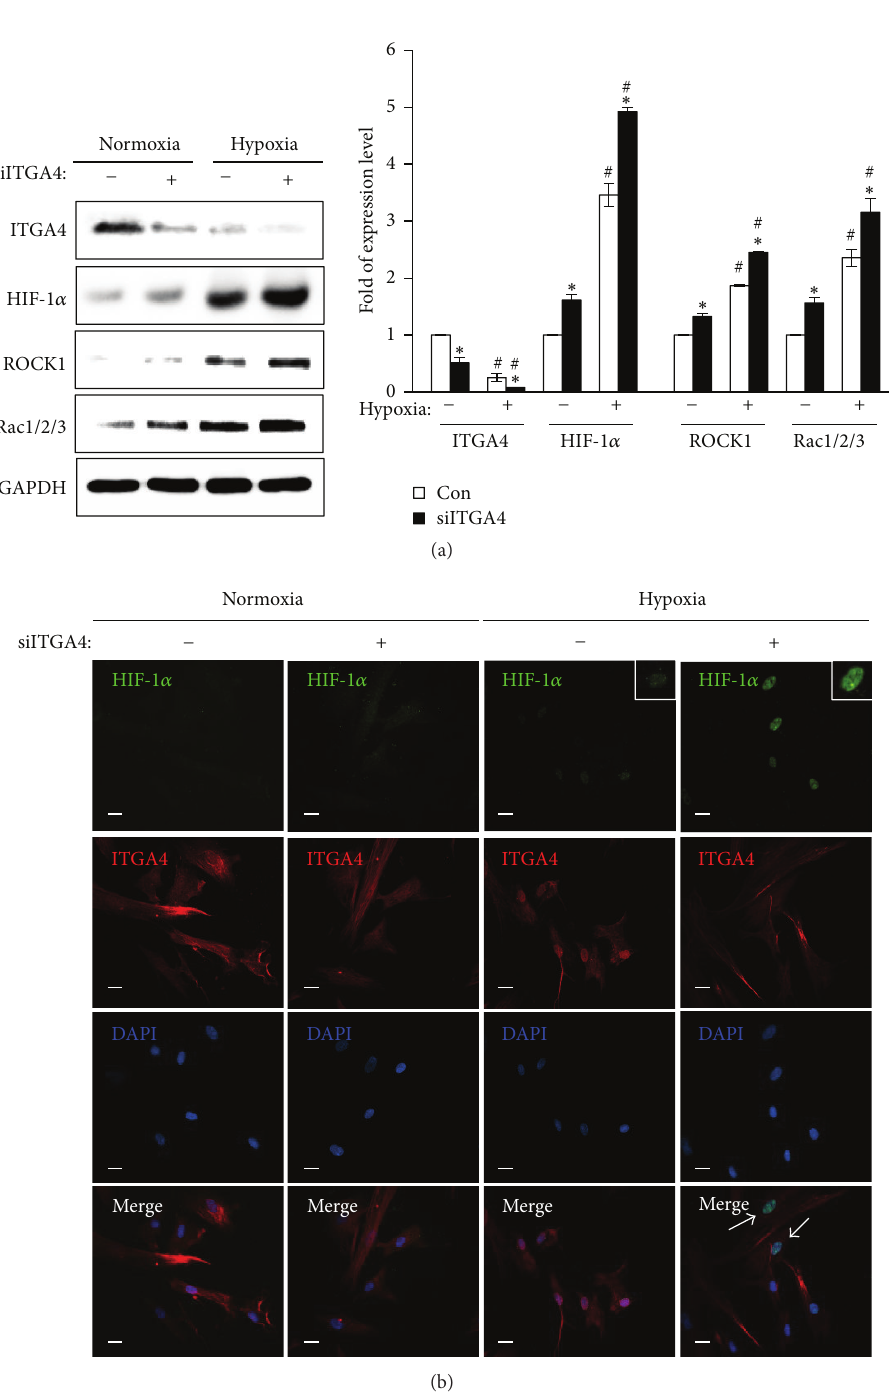
Figure 5: Interaction between integrin 𝛼 4 and HIF-1 𝛼 and its effect on expression of Rho GTPases under hypoxia. (a) Protein expression levels of integrin 𝛼 4 , HIF-1 𝛼 , ROCK1, and Rac1/2/3 were assessed by Western blotting. GAPDH was used as the loading control. (b) HIF-1 𝛼 and integrin 𝛼 4 were localized with immunofluorescence in BM-MSCs after siITGA4 transfection under normoxic or hypoxic conditions. Blue: DAPI; green: HIF-1 𝛼 ; red: integrin 𝛼 4 . Scale bar = 80 𝜇 m (400x original magnification). ∗ 𝑃 < 0.05 (compared with siITGA4 nontransfected group) and # 𝑃 < 0.05 (compared with normoxic group). DAPI: 4 󸀠 ,6-diamidino-2-phenylindole; HIF-1 𝛼 : hypoxia-inducible factor-1 𝛼 ; ITGA4: integrin 𝛼 4 ; ROCK1: Rho-associated kinase 1; siITGA4: integrin 𝛼 4